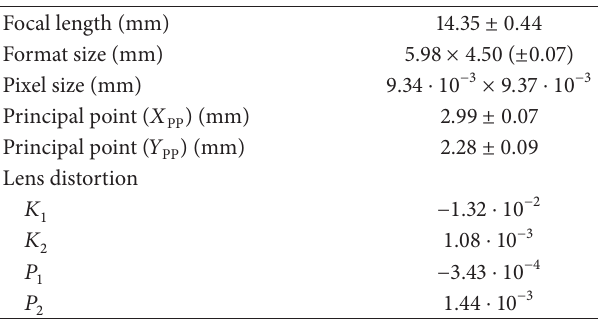
Table 1: Parameters for the geometric calibration of the IR camera